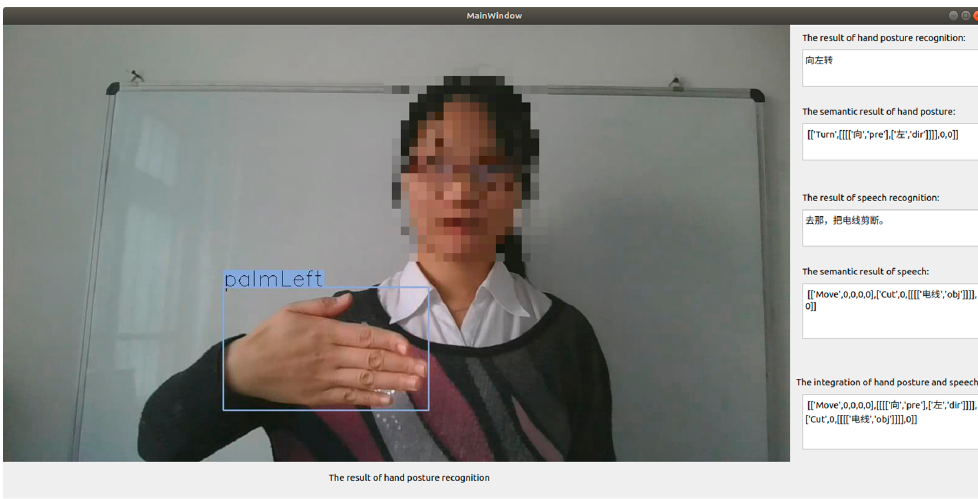
Figure 24. Results of the integration of deictic hand posture and spoken instructions. Appl. Sci. 2020 , 10 , x FOR PEER REVIEW